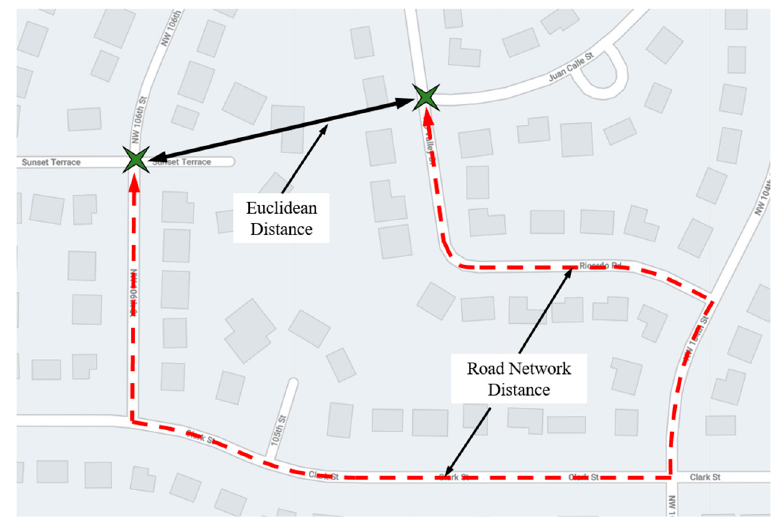
Figure 1. Euclidean distances versus road network distances.